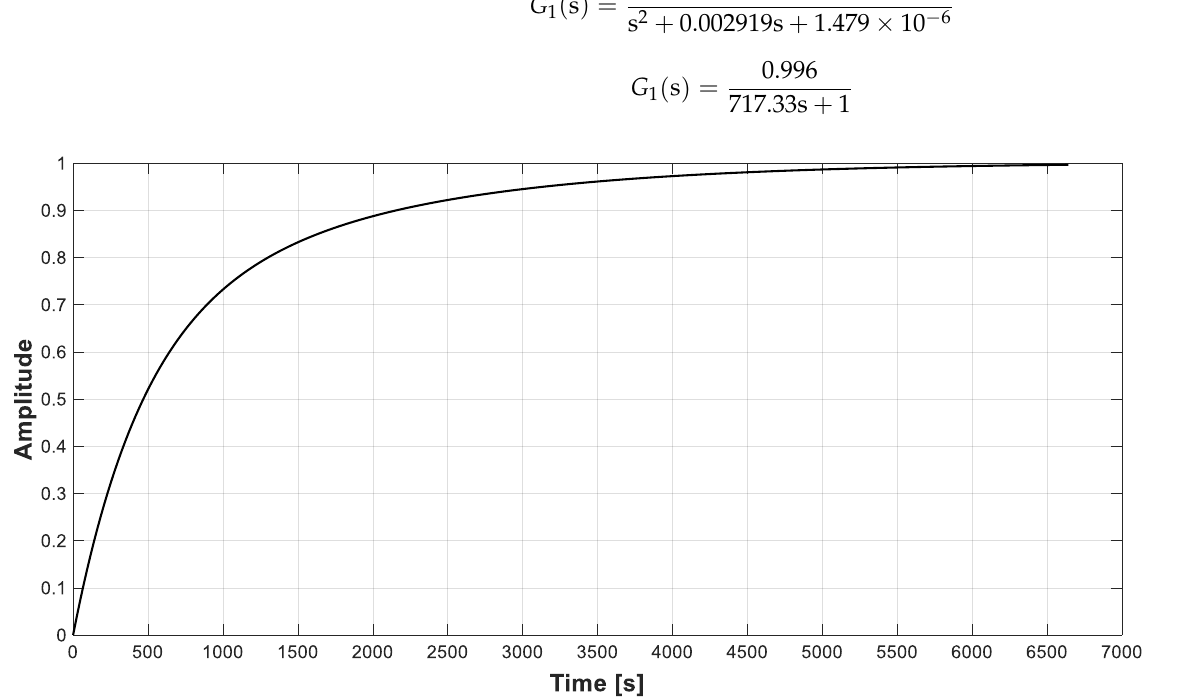
Figure 9. Step response of the main path of the storage tank model.